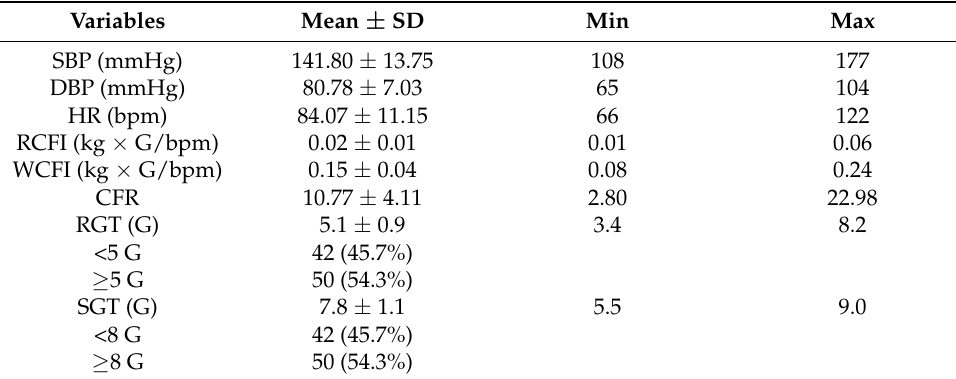
Table 2. Descriptive analysis of physiological parameters.